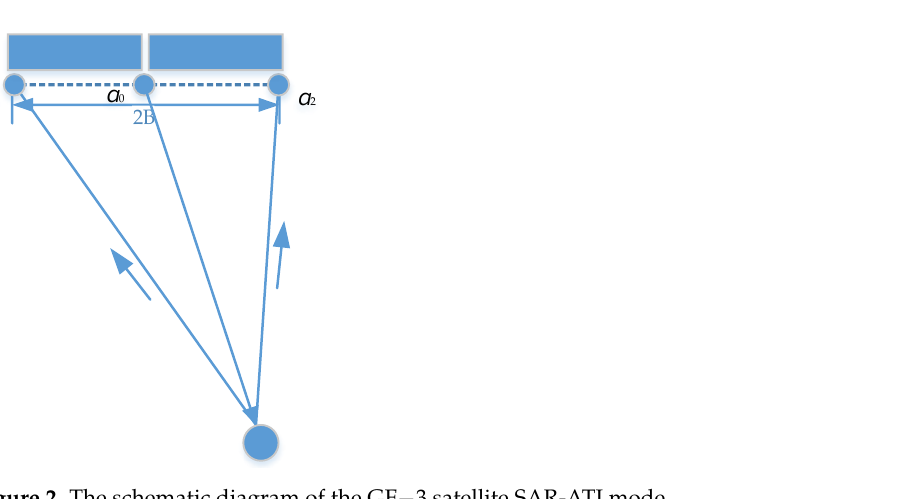
Figure 2. The schematic diagram of the GF − 3 satellite SAR-ATI mode. Table 2. The radar parameters of the GF − 3 satellite.